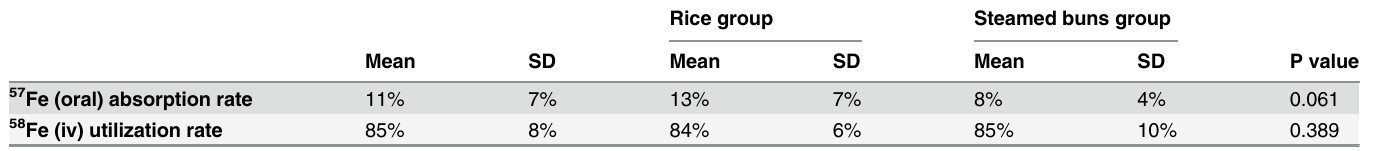
Table 6. Subjects ’ iron absorption and utilization